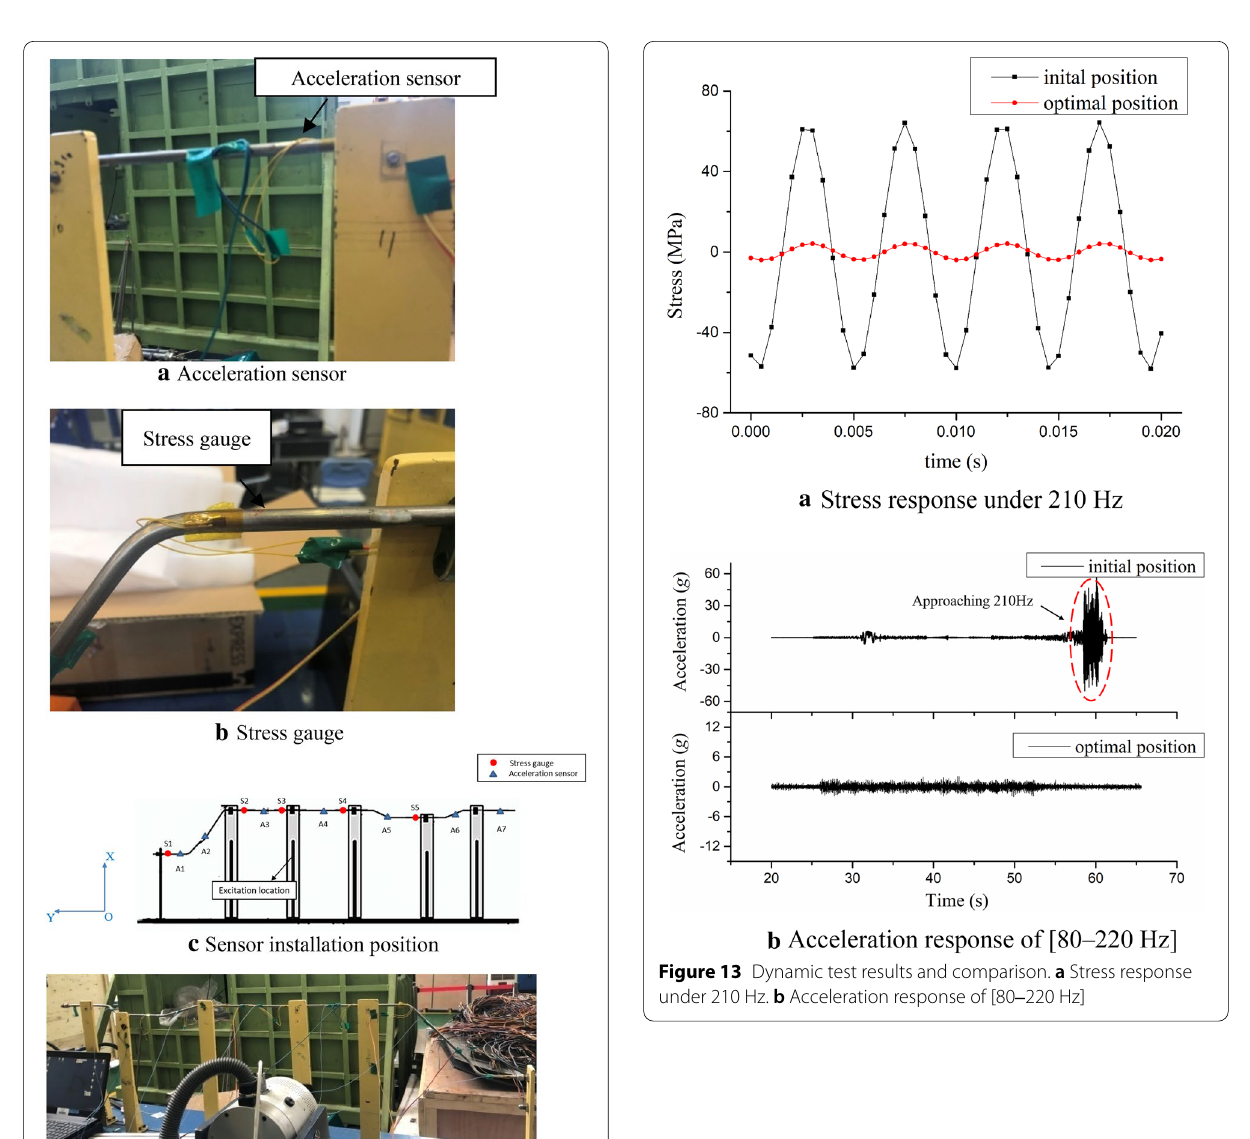
Table 8 Comparison of dynamic responses of [80 ‒ 220